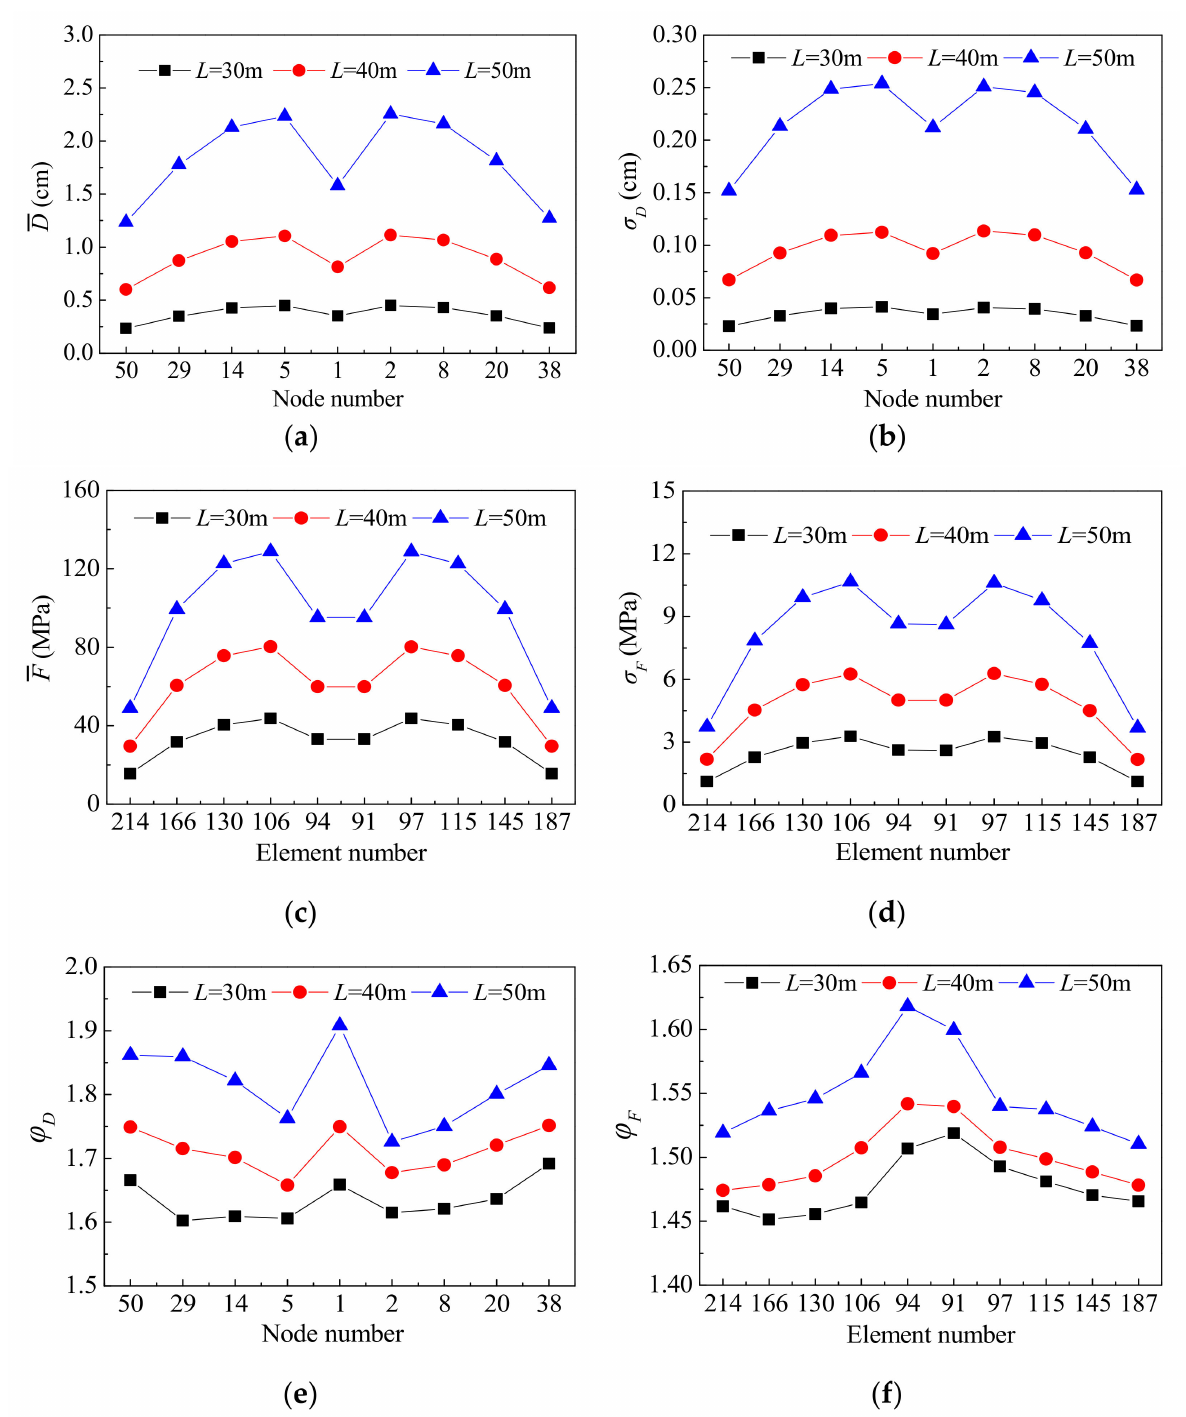
Figure 4. Structural responses versus different spans: ( a ) mean displacements of nodes; ( b ) mean square displacements of nodes; ( c ) mean internal forces of elements; ( d ) mean square internal forces of elements; ( e ) DVCs of nodal displacement; ( f ) DVCs of elemental internal